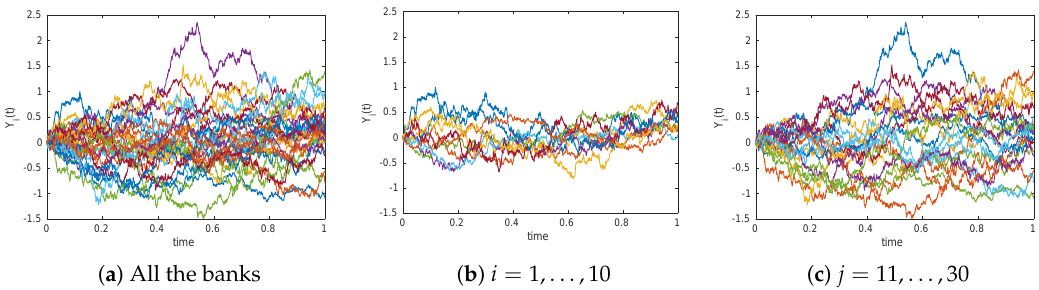
Figure 2. Evolution of the logarithmic capital Y i ( t ) of banks, i = 1, . . . , N . We use the following parameters: interest rate r = 0, N = 30 banks, time horizon T = 1, no correlation: ρ 0 = 0, interbank flows c i , j are as in Equation (38), 1000 time steps, and µ i , σ i , i = 1, . . . , N are i.i.d. uniform on [ 0.1,0.2 ]